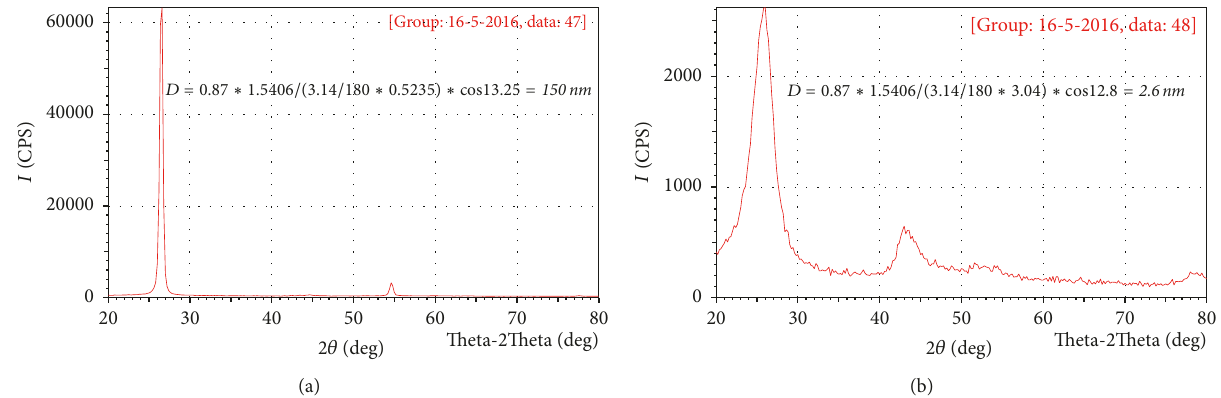
Figure 5: The XRD spectrums for the started graphite flakes (a) and the produced GO (b).